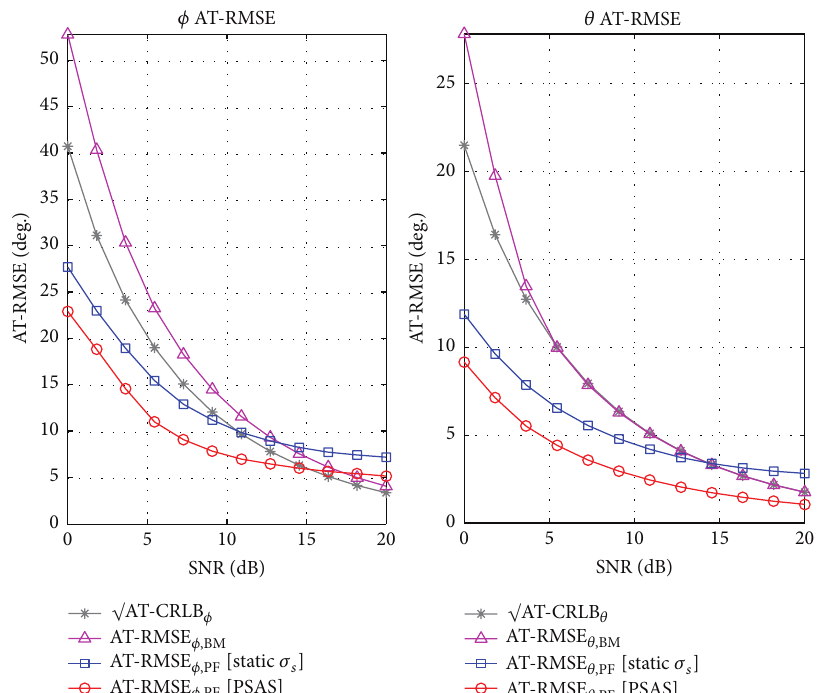
Figure 3: AT-RMSE for different SNR